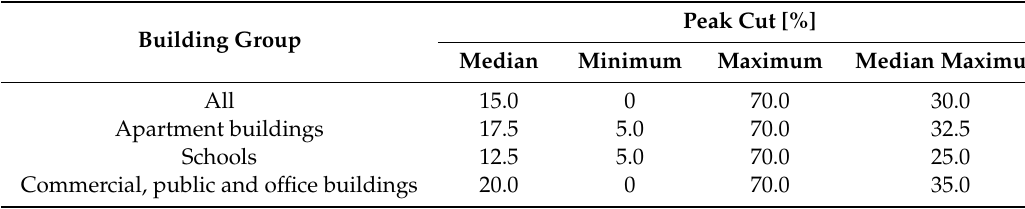
Table 3. Peak load cut in different building groups.